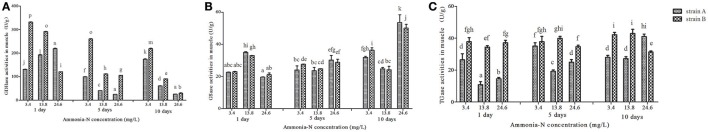
The activities (Mean ± SE) of GDHase, GSase and TGase in the muscle of strains A and B of L. vannamei in 1, 5 and 10 days exposure to different concentrations of ammonia-N. Each bar represents mean value from three determinations with standard error. Data in the same exposure time with different letters are significantly different (p < 0.05) between treatments. (A) GDHase activity in the muscle of strain A and B. (B) GSase activity in the muscle of strain A and B. (C) TGase activity in the muscle of strain A and B. Keys: GDHase, Glutamate dehydrogenase; TGase, Transglutaminase; GSase, Glutamine synthetase.